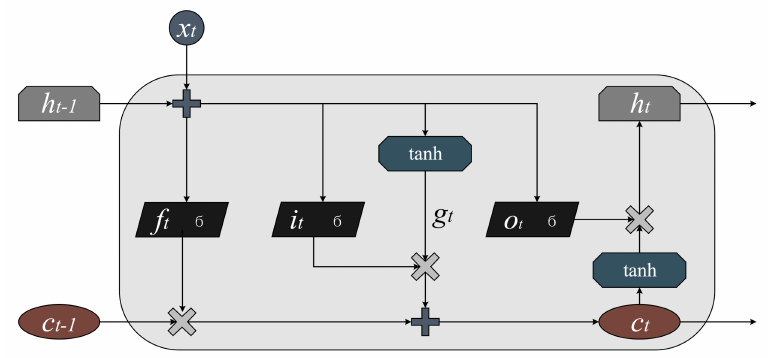
Figure 4. Long short-term memory (LSTM) model structure in a single time step (where c t is the long-term state, h t is the short-term state, i t is the input gate, f t is the forget gate, o t is the output gate, x t is the current time input, c t − 1 is the previous long-term state, h t − 1 is the previous short-term state, σ is the sigmoid function, and tanh is the activation function of the hidden